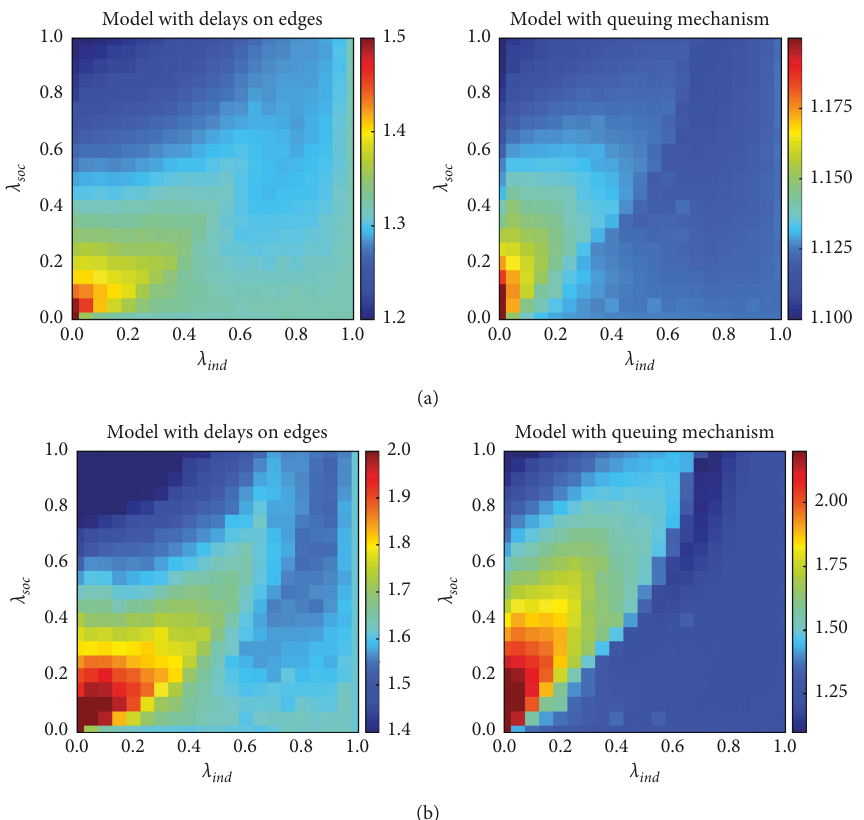
Figure 6: Aggregated results for expected driving times. Each cell corresponds to single combination of λ for all simulation’s iterations which represents percentage change in average driving time for all edges in traffic network compared to scenario where cars are driving with maximum velocity (a) and standard deviation of those changes